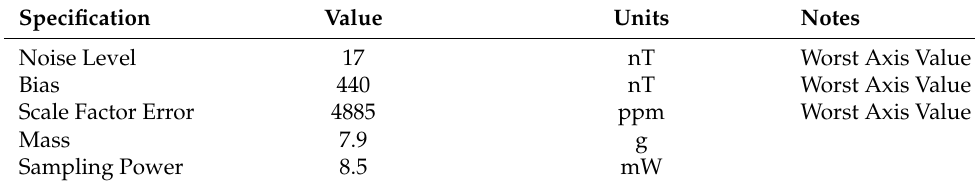
Table 5. PNI RM3100 magnetometer specifications.